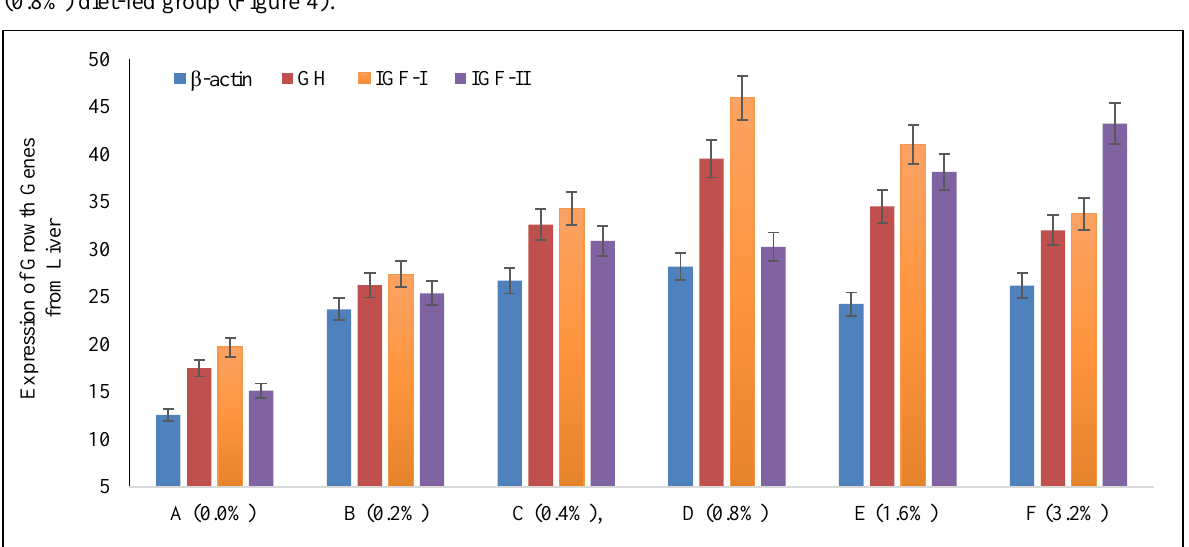
Figure 4. Growth hormone (GH) and insulin-like growth factor (IGF-I and IGF-II) genes relative expression levels to β- actin determined by real-time PCR in the head-kidney of silver carp fed six varied LFE supplemented diets for 90 days. Data represent as means ± standard error (n = 10).